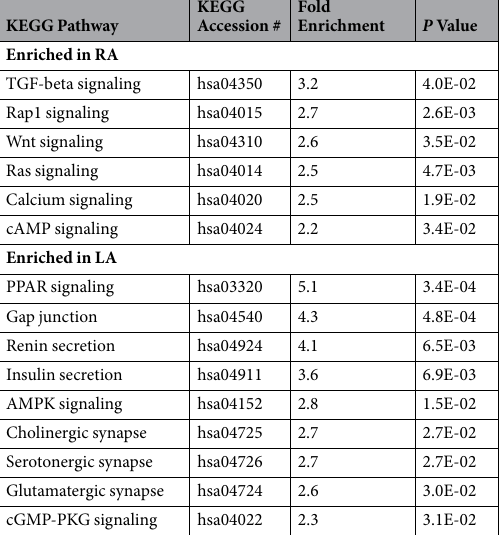
Table 2. Examples of Differentially Enriched Signaling Pathways in Non-Failing Human Right and Left Atria 1 . 1 Kyoto Encyclopedia of Genes and Genomes (KEGG) pathways differentially represented in the paired RA (N = 8) and LA (N = 8) samples, determined as described in Methods and